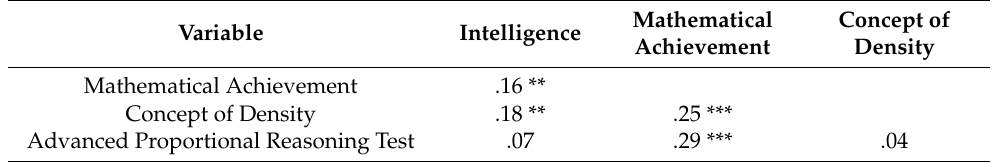
Table 2. Bivariate correlations in Study 1.